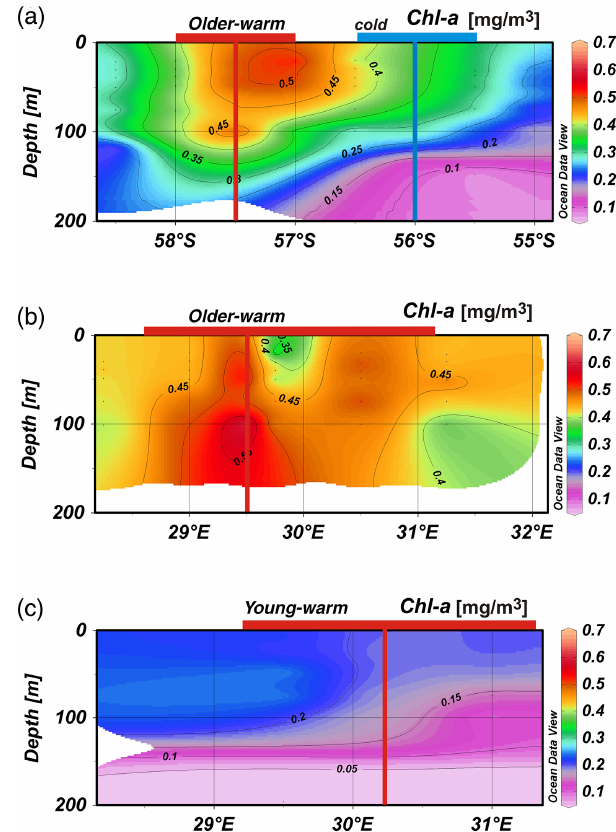
Figure 6. Chlorophyll a profiles, plotted to a depth of 200m, for Transect E1 ( a and d ), Transect E2 ( b and e ) and Transect E3 ( c and f ). Vertical red and blue lines represent the eddy cores as described for Fig. 3. The data available online can be used to reproduce these Ocean Dataviewer plots to shallower or deeper